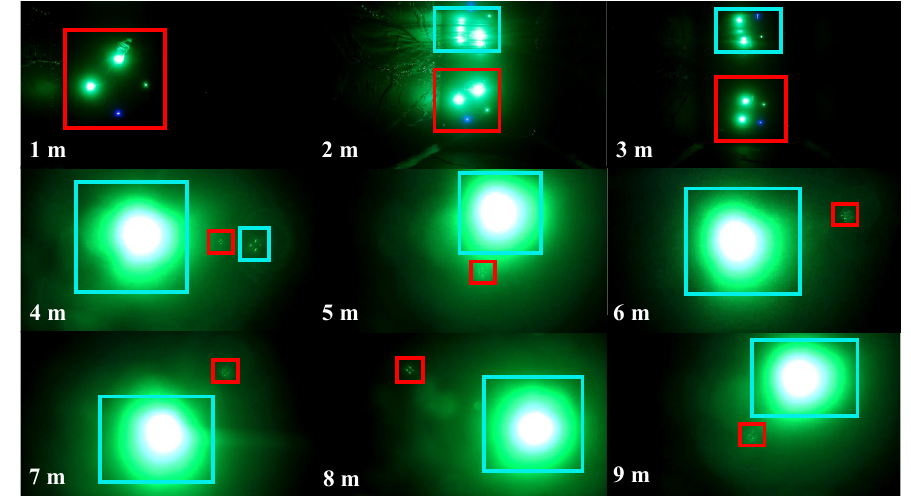
Figure 8. Pictures of LED and LD optical beacons collected within 1–10 m.